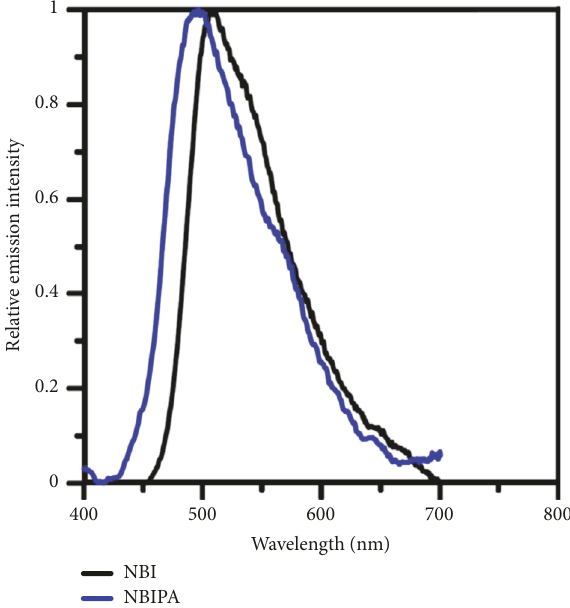
Figure 6: Normalized fluorescence spectra of NBI (powder) and NBIPA electrospun